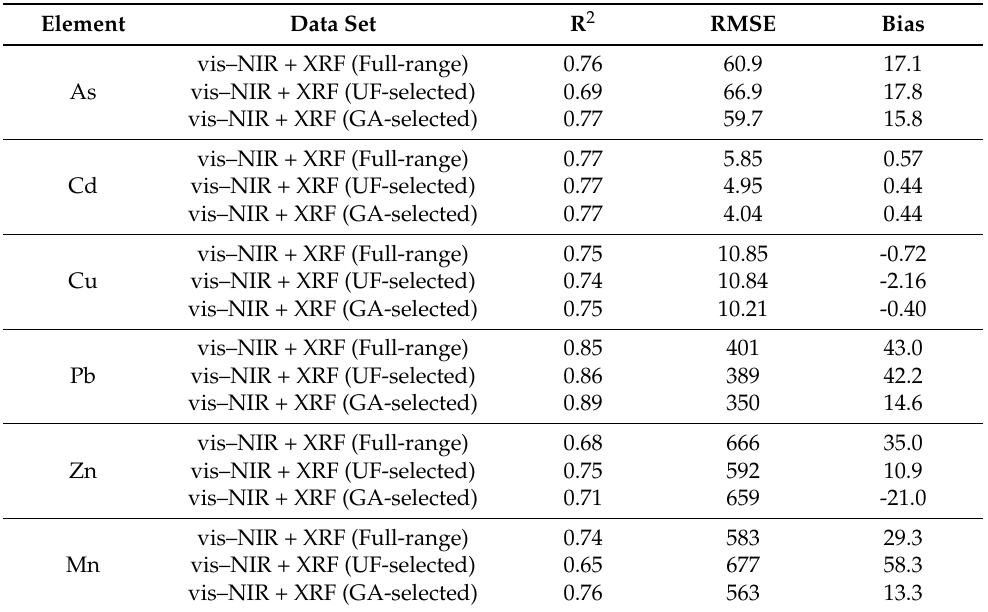
Table 4. Statistics of the prediction model performance for soil PTEs concentration (mg/kg) using the fused spectra (validation data